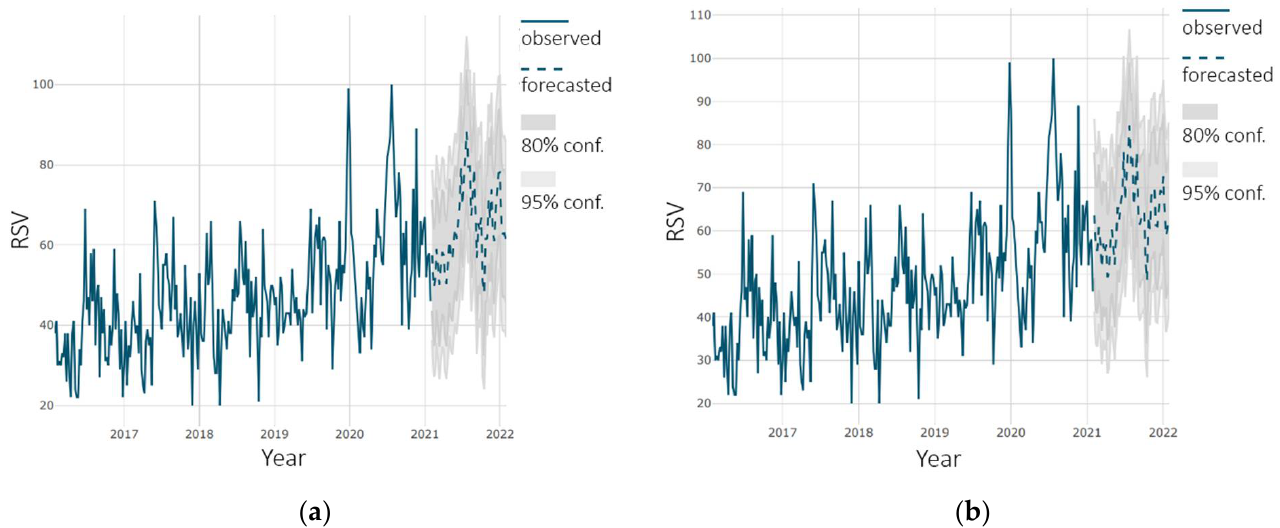
Figure 6. Forecast of interest in “pneumo” vaccine: ( a ) by using SARIMA model; ( b ) using tslm model.